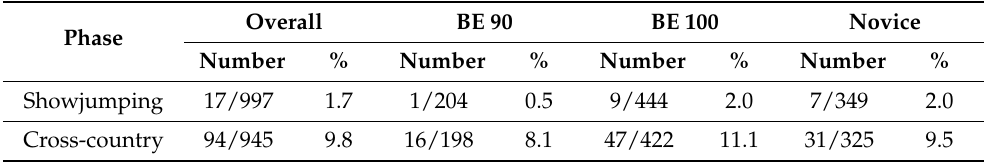
Table 6. Eliminations or retirements during showjumping or cross-country related to the number of competition starts, accounting for withdrawals or previous elimination, for British Eventing (BE) 90, 100 and Novice competitions.